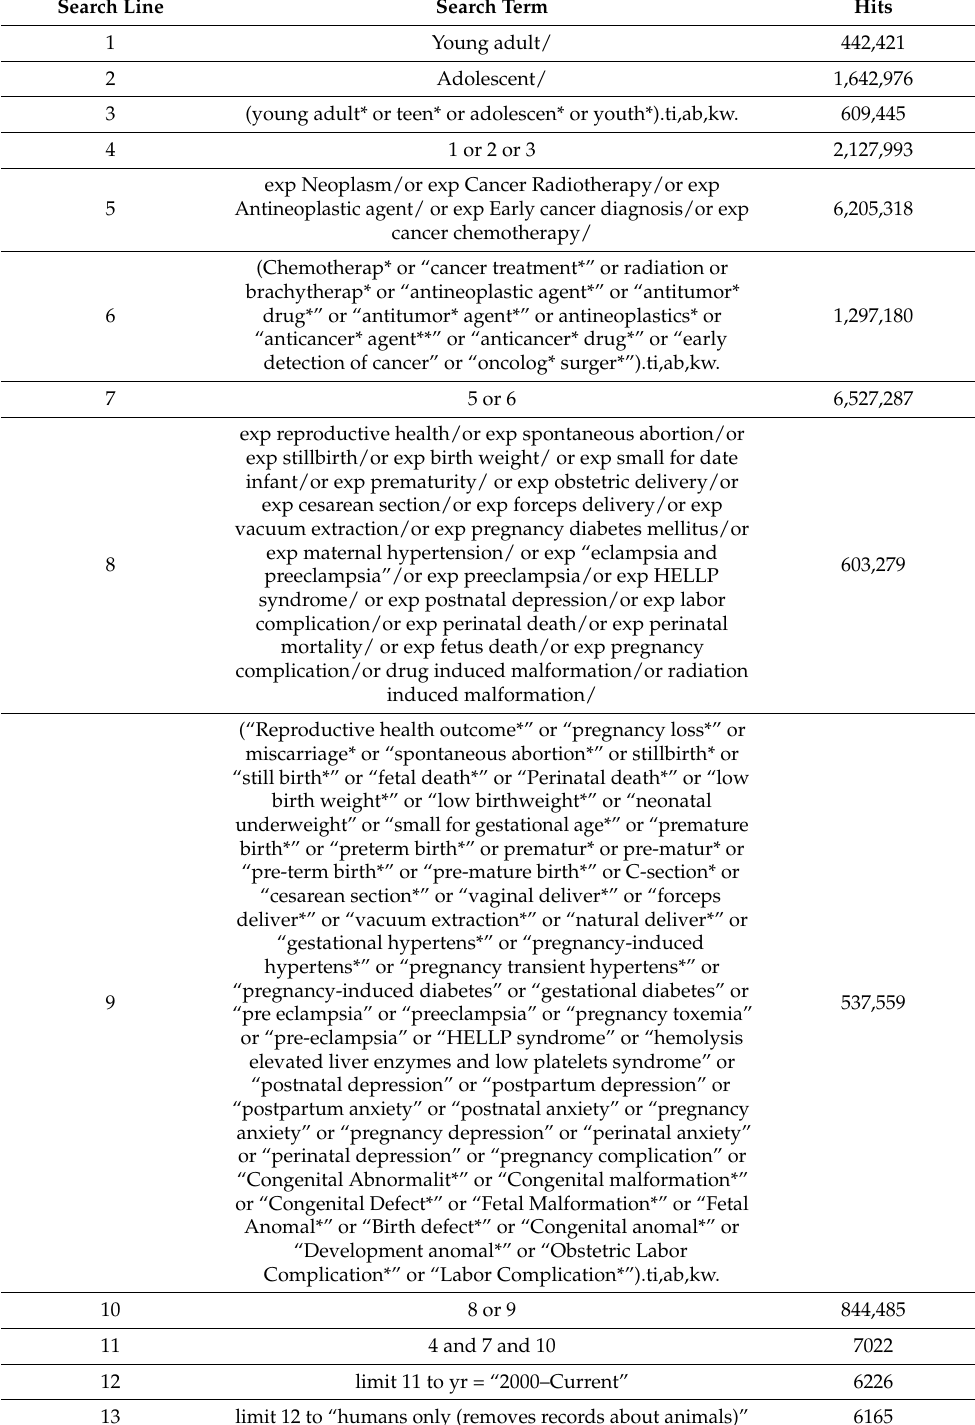
Table 1. EMBASE Ovid Search (1974 to 26 January